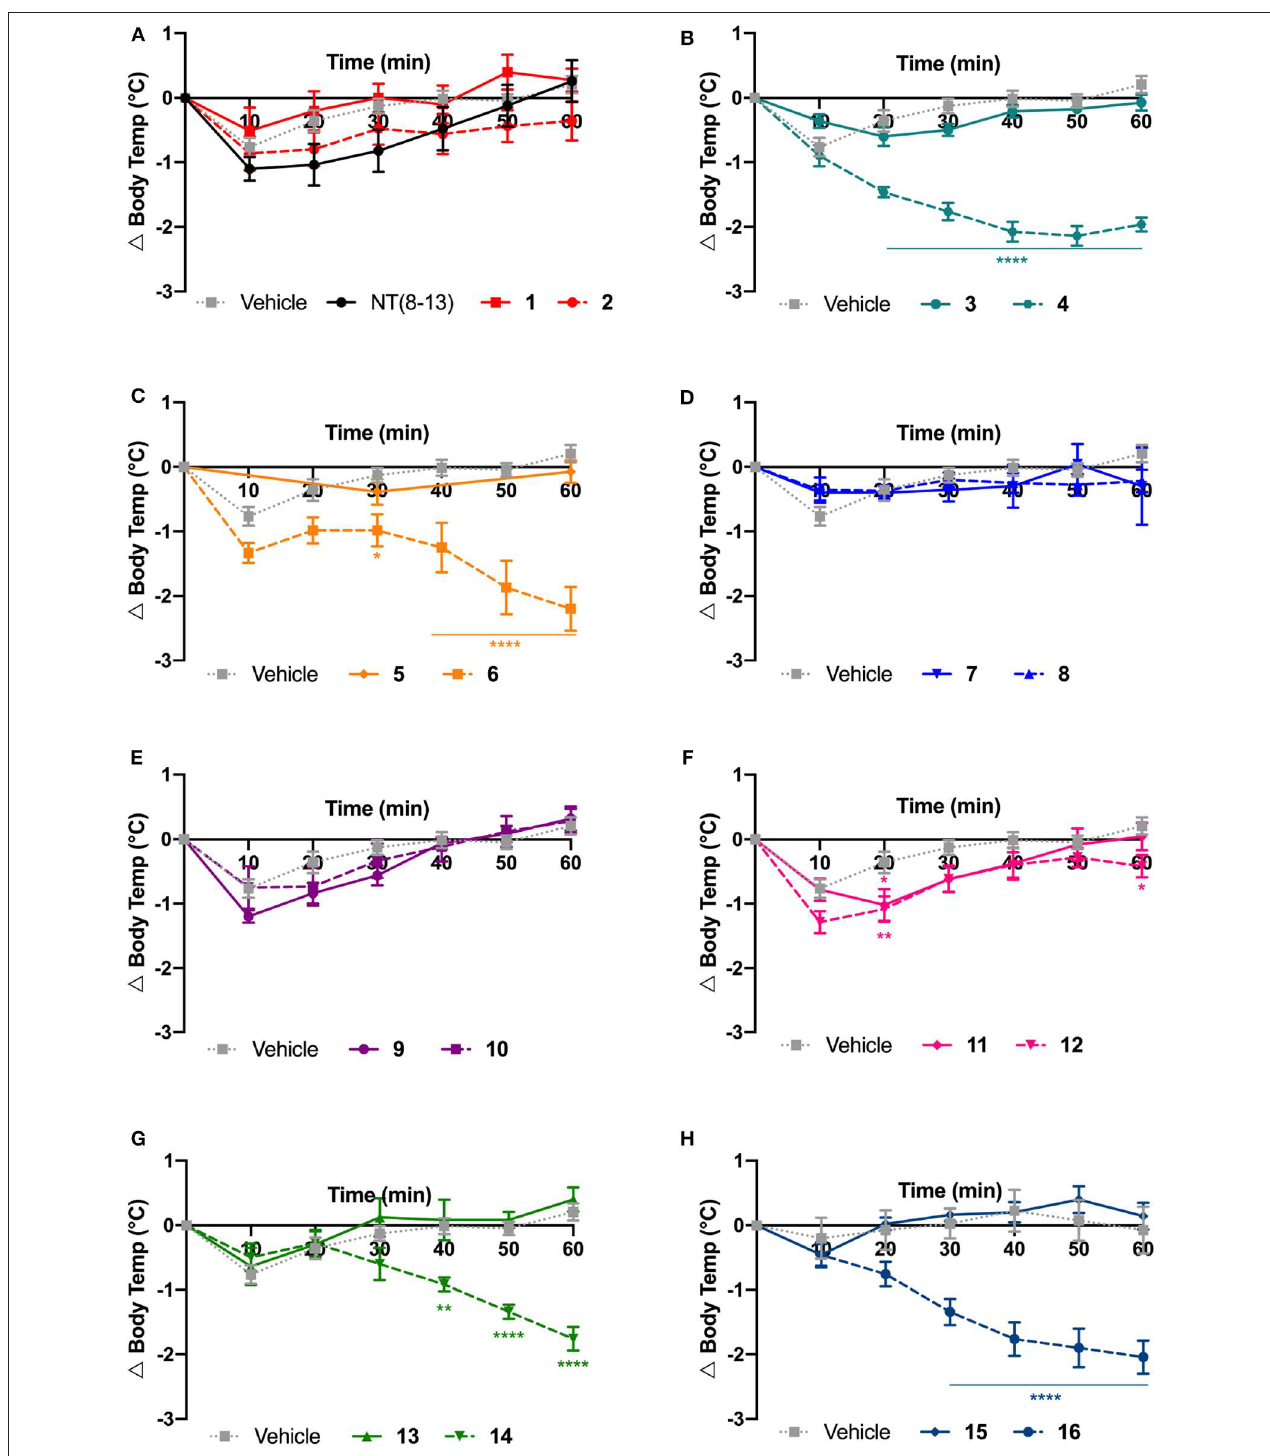
FIGURE 3 | Physiological effects of NT(8-13) analogs on body temperature. Change in body temperature ( 1 Body temp) was calculated at 10min intervals over 1h following their intrathecal injection at 30 µ g/kg (A-H) . For each specific pair, compounds with (dotted line) or without (solid line) reduced amide bounds were represented on the same graph ( n = 5 to 20 rats per group). Error bars represent mean ± SEM. A two-way ANOVA followed by Bonferroni’s multiple comparisons test was performed. * p < 0.05; ** p < 0.01; **** p < 0.0001; as compared to vehicle-injected rats.